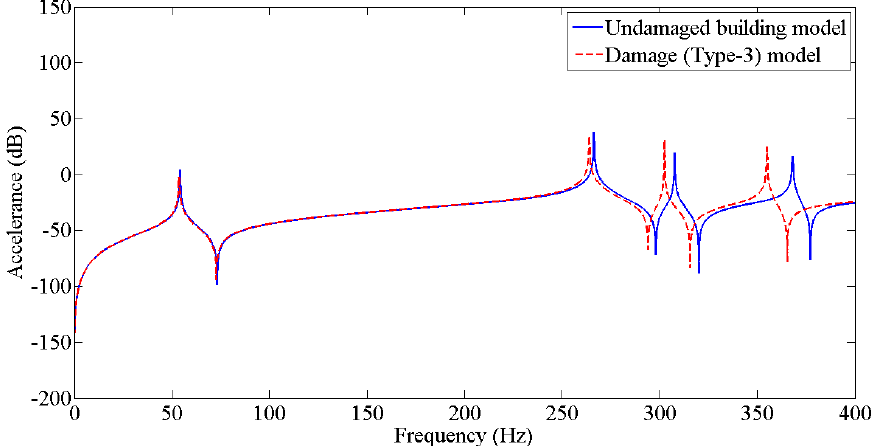
Figure 8. Prediction of structural dynamic behavior of building model under undamaged and dam- aged (Type − 3) conditions through FRFs.